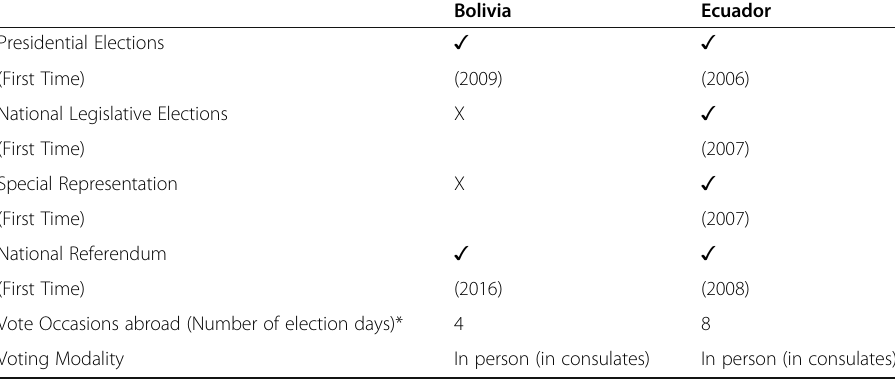
Table 2 The Electoral Systems of Bolivia and Ecuador